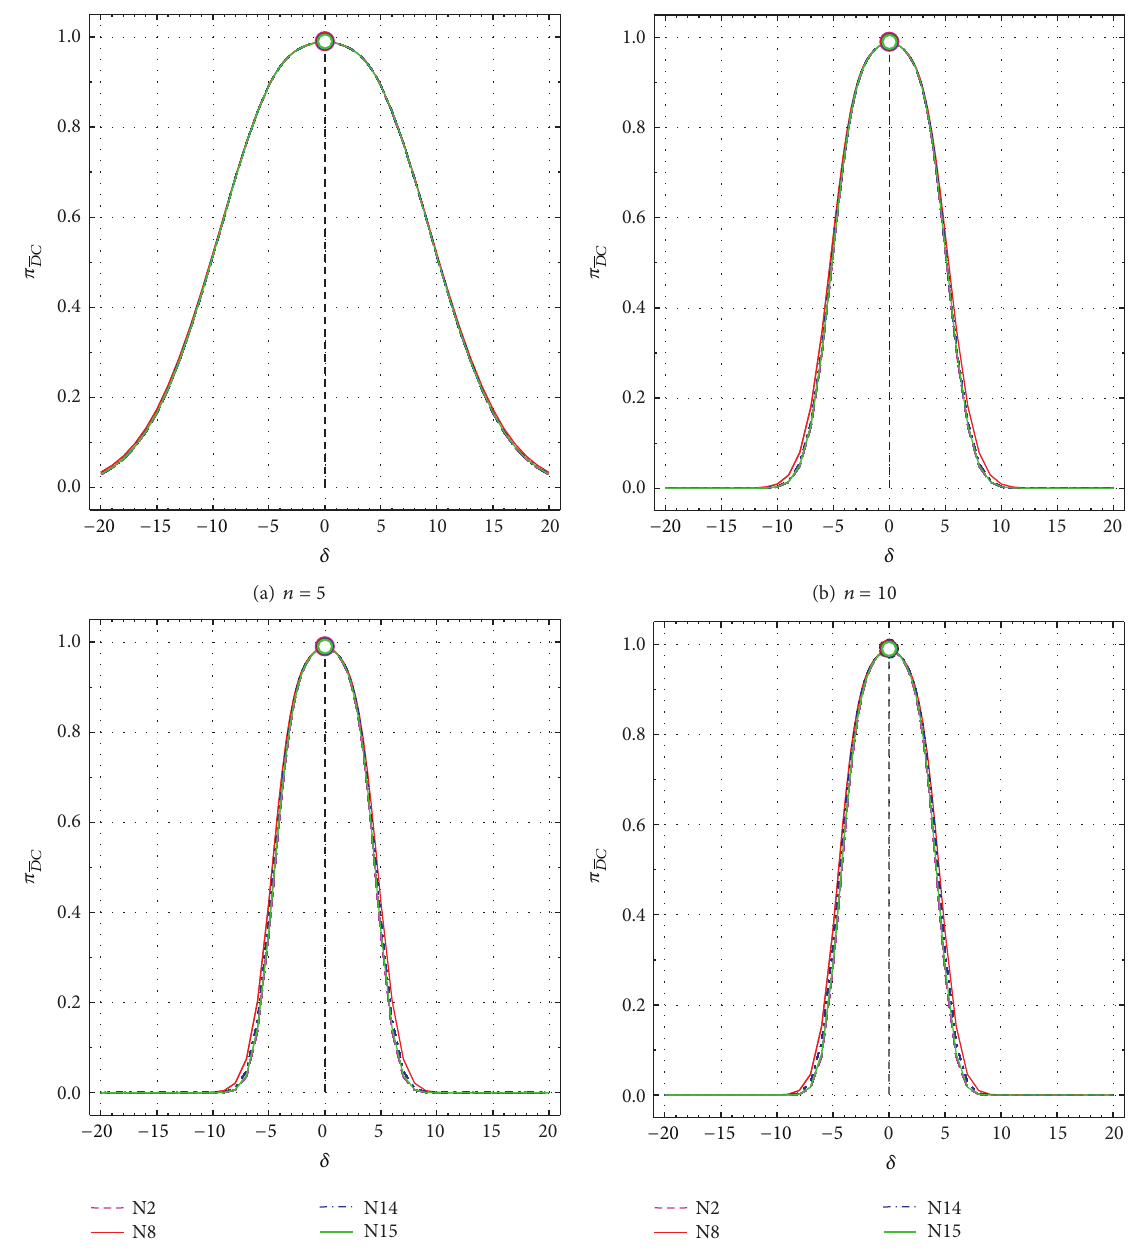
Figure 5: Nonspurious type II error probability ( 𝜋 𝐷𝐶 ) as a function of 𝛿 from − 20 to +20 for all tests N2, N8, N14, and N15. 𝜋 𝐷𝐶 values for uncontaminated samples ( 𝛿 = 0 ) are shown by open circles. (a) 𝑛 = 5 ; (b) 𝑛 = 10 ; (c) 𝑛 = 15 ; and (d) 𝑛 = 20